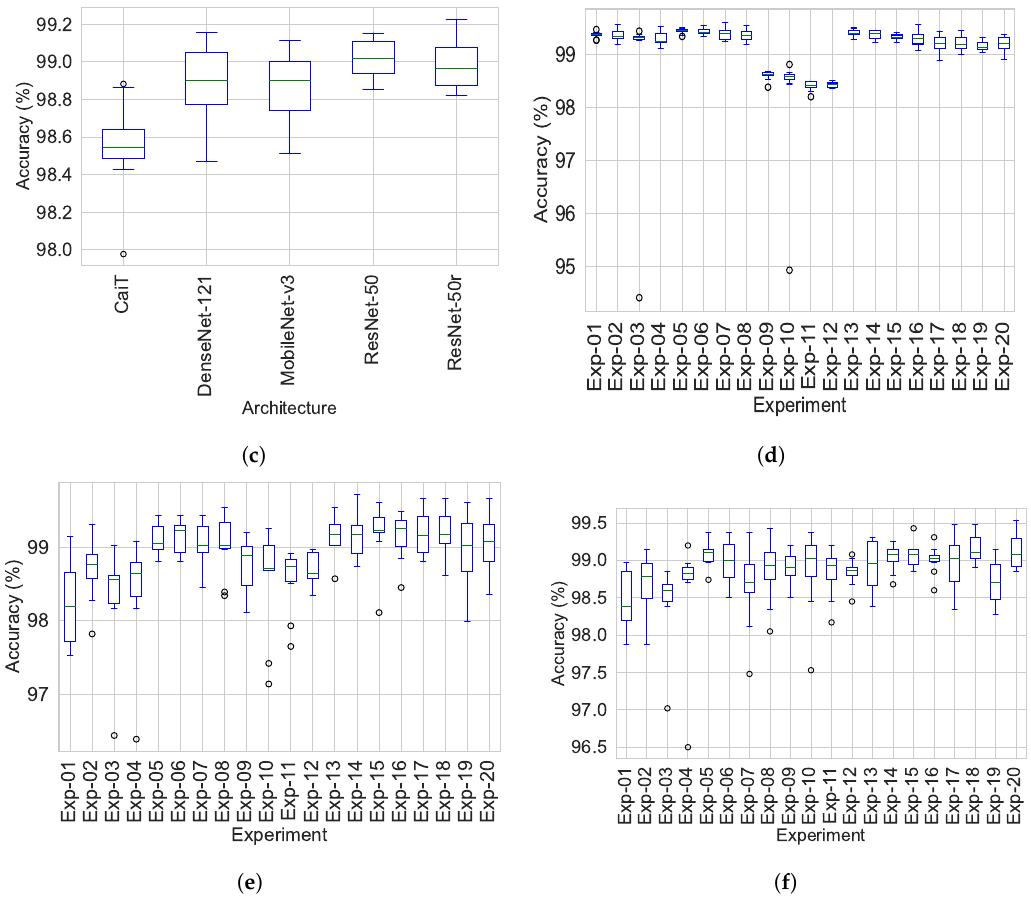
Figure 4. Train, validation and test accuracy before the bootstrapping cycle by network and experi- ment. ( a ) Train accuracy by architecture. ( b ) Validation accuracy by architecture. ( c ) Test accuracy by architecture. ( d ) Train accuracy by experiment. ( e ) Validation accuracy by experiment. ( f ) Test accuracy by